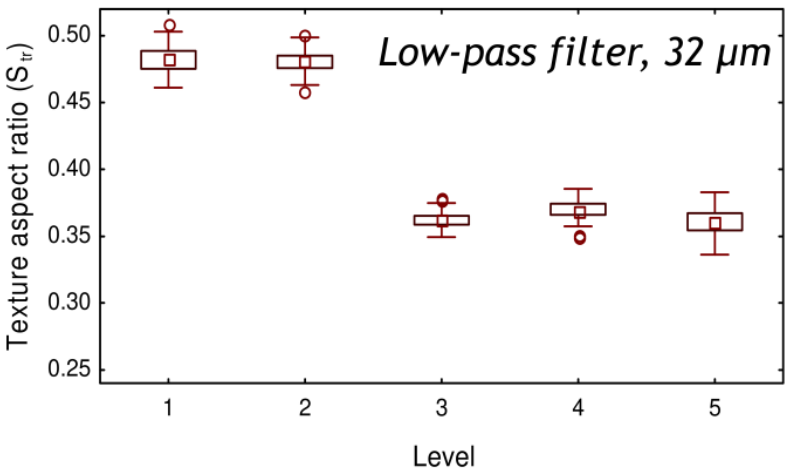
Figure 4. Texture aspect ratio S tr values obtained with a low-pass filter of 32 µ m as a function of the visual roping levels after tensile testing.